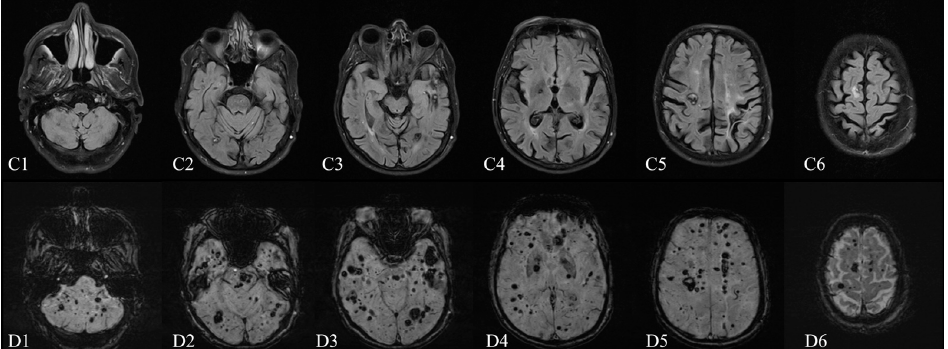
Figure 2. Brain MRI (1.5 T)—January 2021: ( C1 – C6 ) axial FLAIR sequence and ( D1 – D6 ) axial SWI sequence (TE 40.00 ms). Compared with the 2015 MRI (1.5 T), the number and the dimensions of